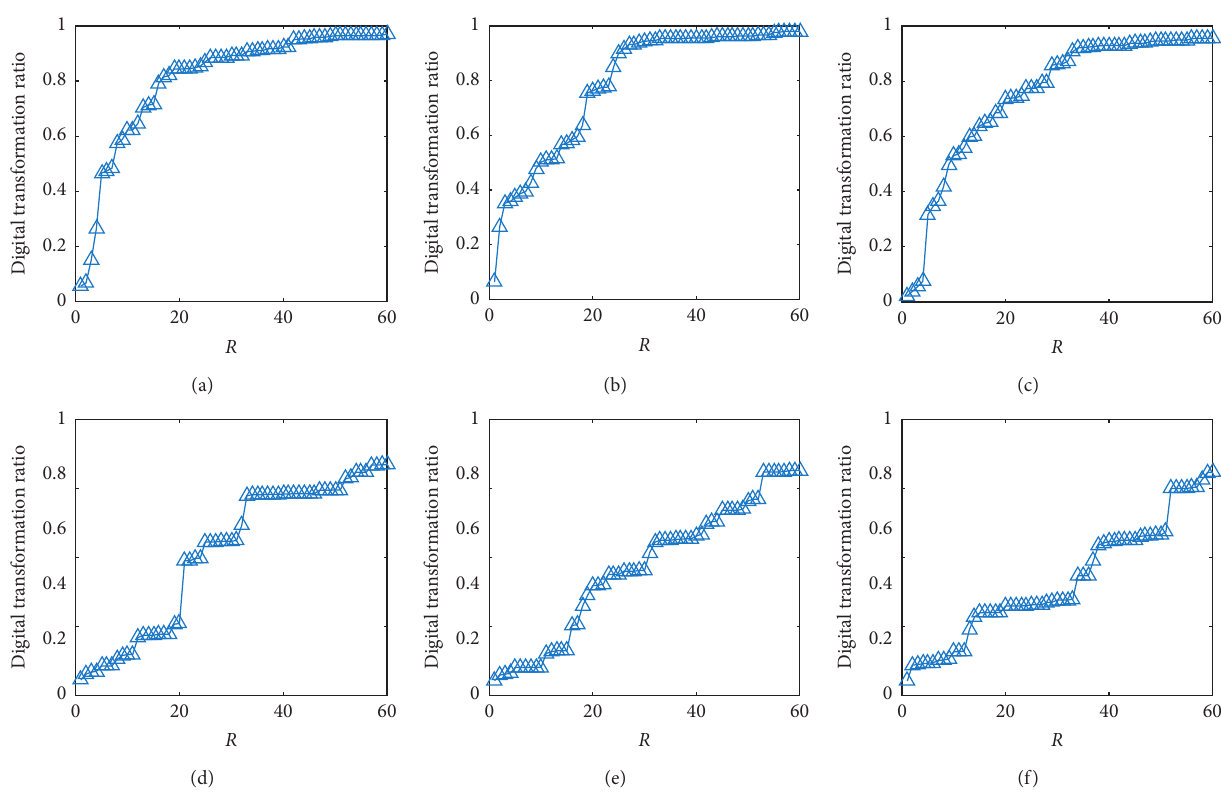
Figure 11: The proportions of enterprises carry out digital transformation under different environmental policies: (a) pr � 0.3, Cu � 1, Cb � 2; (b) pr � 0.5, Cu � 1, Cb � 2; (c) pr � 0.7, Cu � 1, Cb � 2; (d) pr � 0.3, Cu � 2, Cb � 4; (e) pr � 0.5, Cu � 2, Cb � 4; (f) pr � 0.7, Cu � 2, Cb �